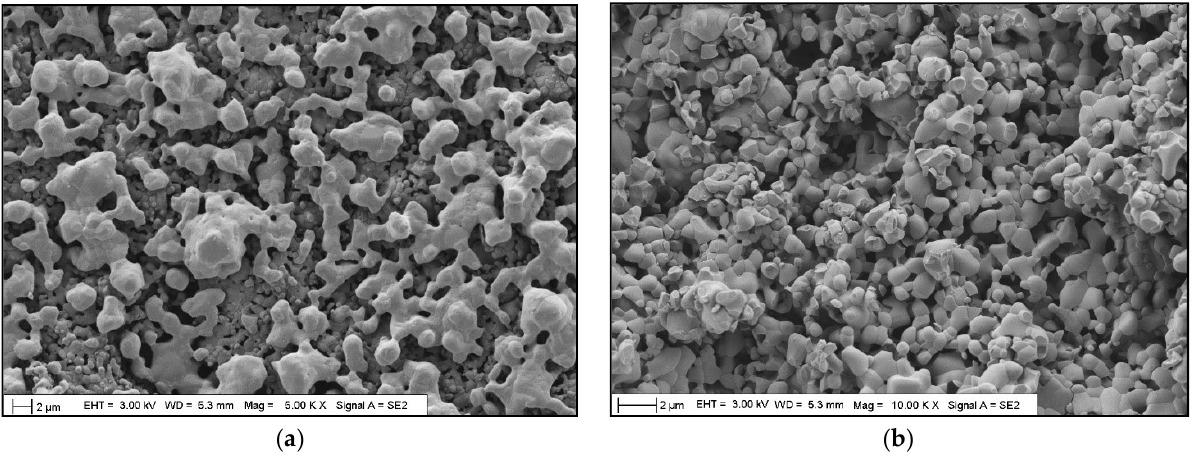
Figure 14. SEM images of the anode support after Exp. III: ( a ) typical surface of the contact layer on the top of the support; ( b ) bare support in the spots of contact layer deficiency.